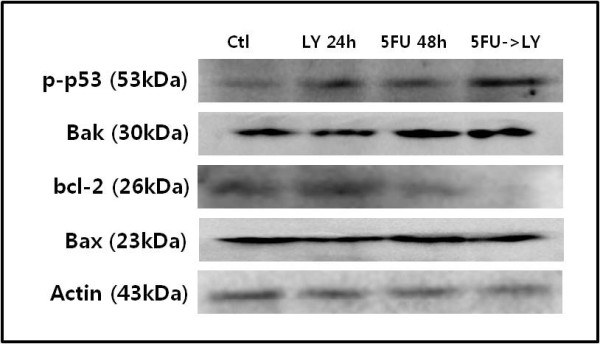
Western blot analysis of Bcl-2 family members (Bak1, Bcl-2, and Bax) and p-p53. The expression of Bak1, Bax, Bcl-2, and β-actin proteins in SNU-719 cells was investigated. Sequential treatment with 5-FU followed by LY2940002 significantly reduced the expression of Bcl-2 protein but slightly increased the expression of Bak1. However, there was no change in the expression of Bax protein.